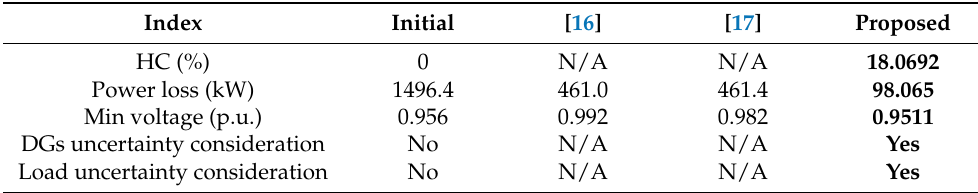
Table 17. A comparison with previous works based on system’s performance indices for the 880-node distribution